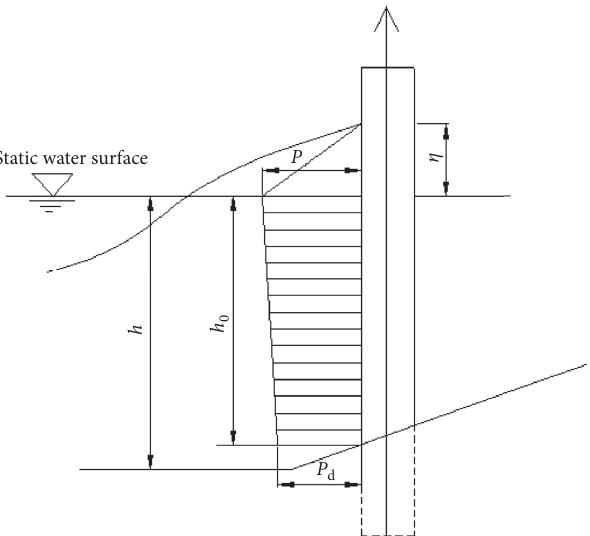
Figure 18: Simplified calculation model of landslide surge wave pressure.